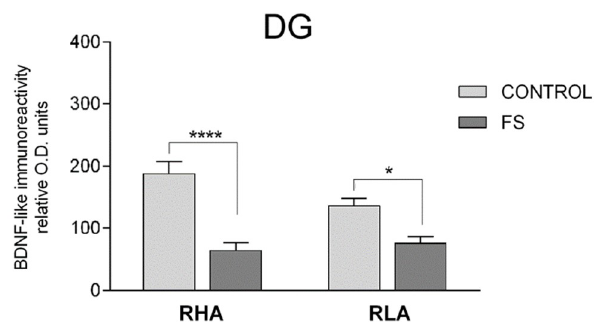
Figure 5. Densitometric analysis of the BDNF-like immunoreactivity in the CA1 and CA3 sectors of the Ammon’s horn, and in the dentate gyrus (DG) of the ventral hippocampus in the baseline conditions (CONTROL) and after forced swimming (FS). Columns and bars denote the mean ± S.E.M. of six rats, in each experimental group. Two different sections were analyzed for each rat. *: p < 0.05; ***: p = 0.0001; ****: p < 0.0001 (Tukey’s post hoc test or Sidak’s correction for multiple comparisons).